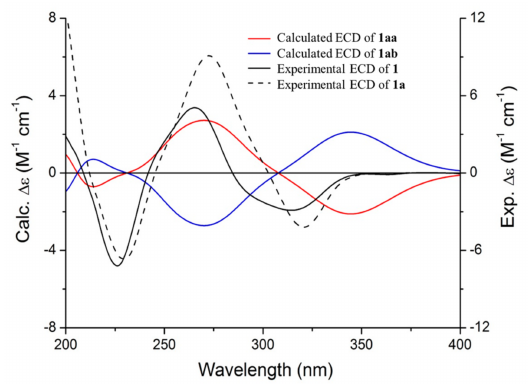
Figure 3. Calculated electronic circular dichroism (ECD) spectra of (8 S ) 1a and (8 R ) 1a -isomers and the experimental ECD of 1a and 1